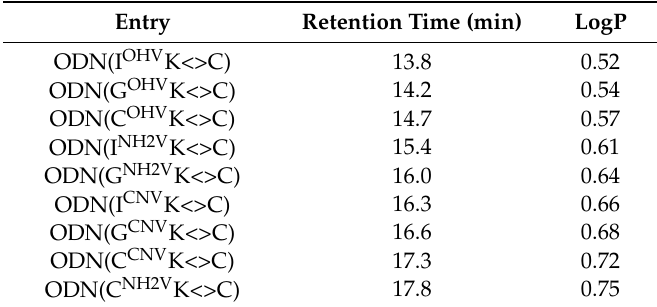
Figure 6. ( a ) Time course of the deamination reactions of the photo-adducts ODN(XK<>C). ( b ) Deamination reaction rate constants of the photo-adducts ODN(XK<>C). The values besides the bars are reaction rate constants and the values in braces indicate the acceleration ratio compared to the case of C CNV K. Photoreaction rate constants were estimated from the time course of the deamination reaction with an assumption of first-order reaction kinetics. Table 2. Partition coefficient